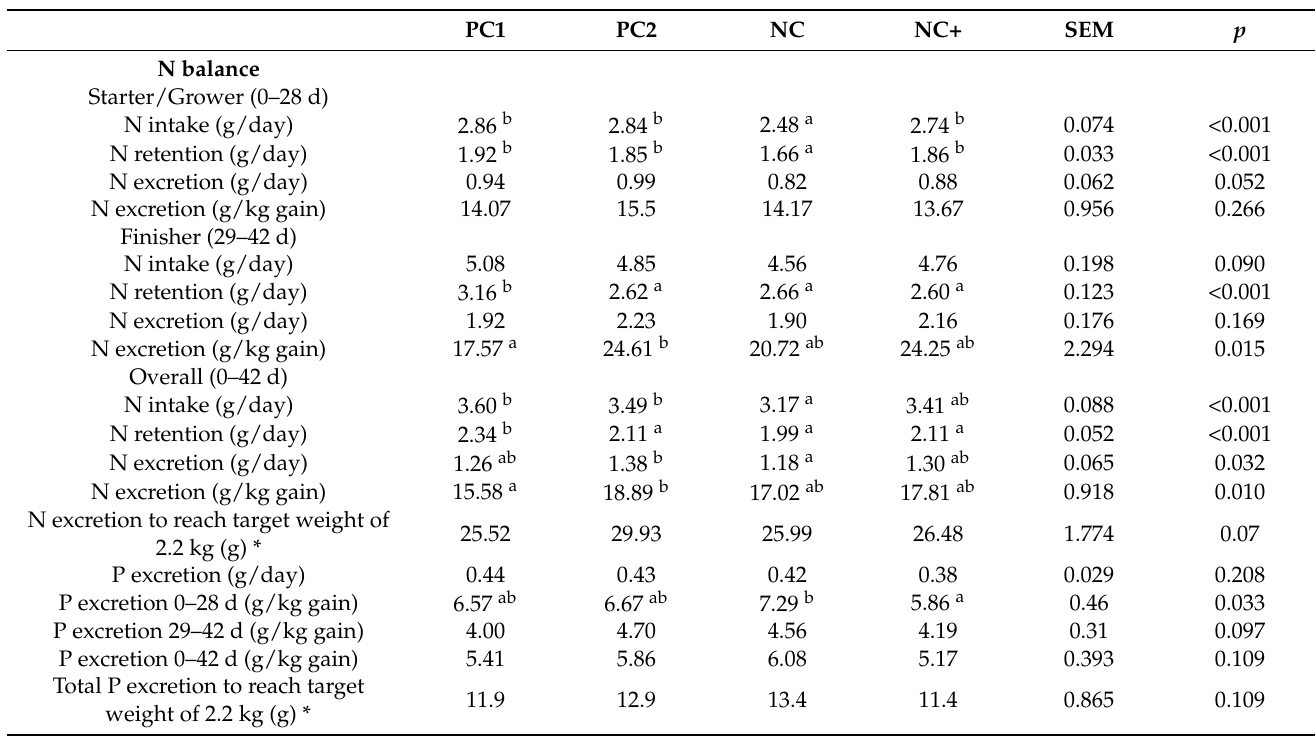
Table 7. Results of N balance and P excretion of broilers fed experimental diets (PC1, PC2, NC